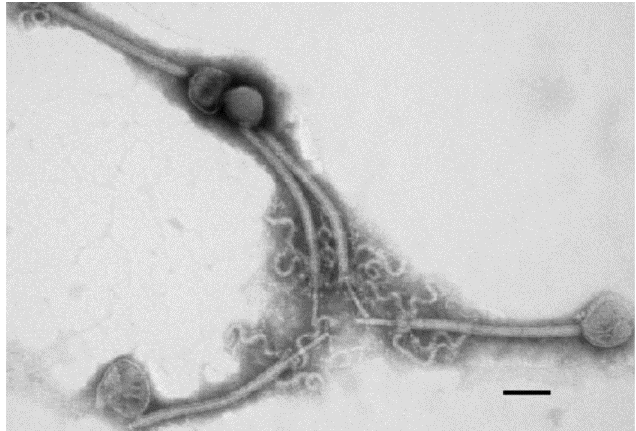
Figure 7. Transmission electron micrograph of phage 0305ϕ8-36. Phage particles are in contact with each other displaying aggregation. The length bar is 0.1 μm; magnification calibration was checked with diffraction grating. The tails of all phages particles have partially contracted. Reproduced from Serwer et al. (2007), Virol. J. (reference